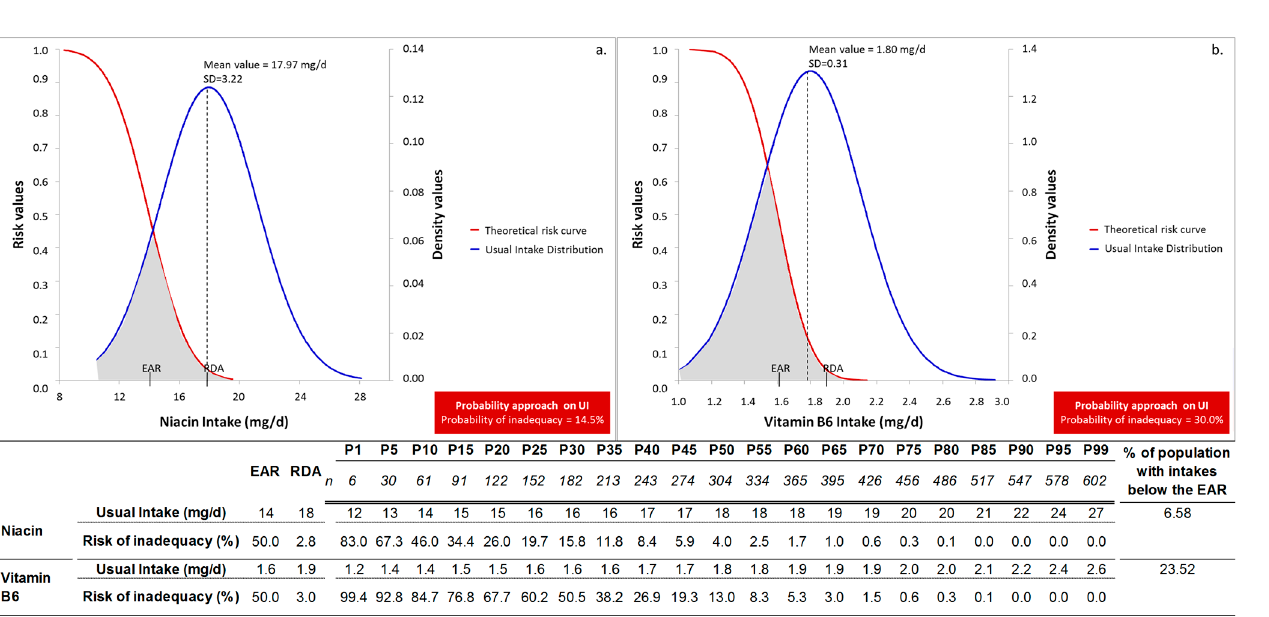
Figure 5. Risk curve and usual intake distributions of the study population for niacin ( a ), and vitamin B6 ( b ), cases of with mean usual intake above the EAR value, but equal/below the RDA value. Risk of inadequacy expresses the corresponding risk attached to each intake; SD: Standard Deviation; UI: Usual Intake; EAR: Estimated Average Requirement; RDA: Recommended Dietary Allowance.